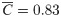
Distribution f(C) of the value of the clustering coefficient C per class for all cities in our dataset.The higher-income class exhibits the highest level of clustering, with an average of C¯=0.83, followed by the lower-income class with on average C¯=0.78. The middle-income class households are significantly less clustered than the other two, with C¯=0.52 on average. The average is computed over all US core-based statistical areas.